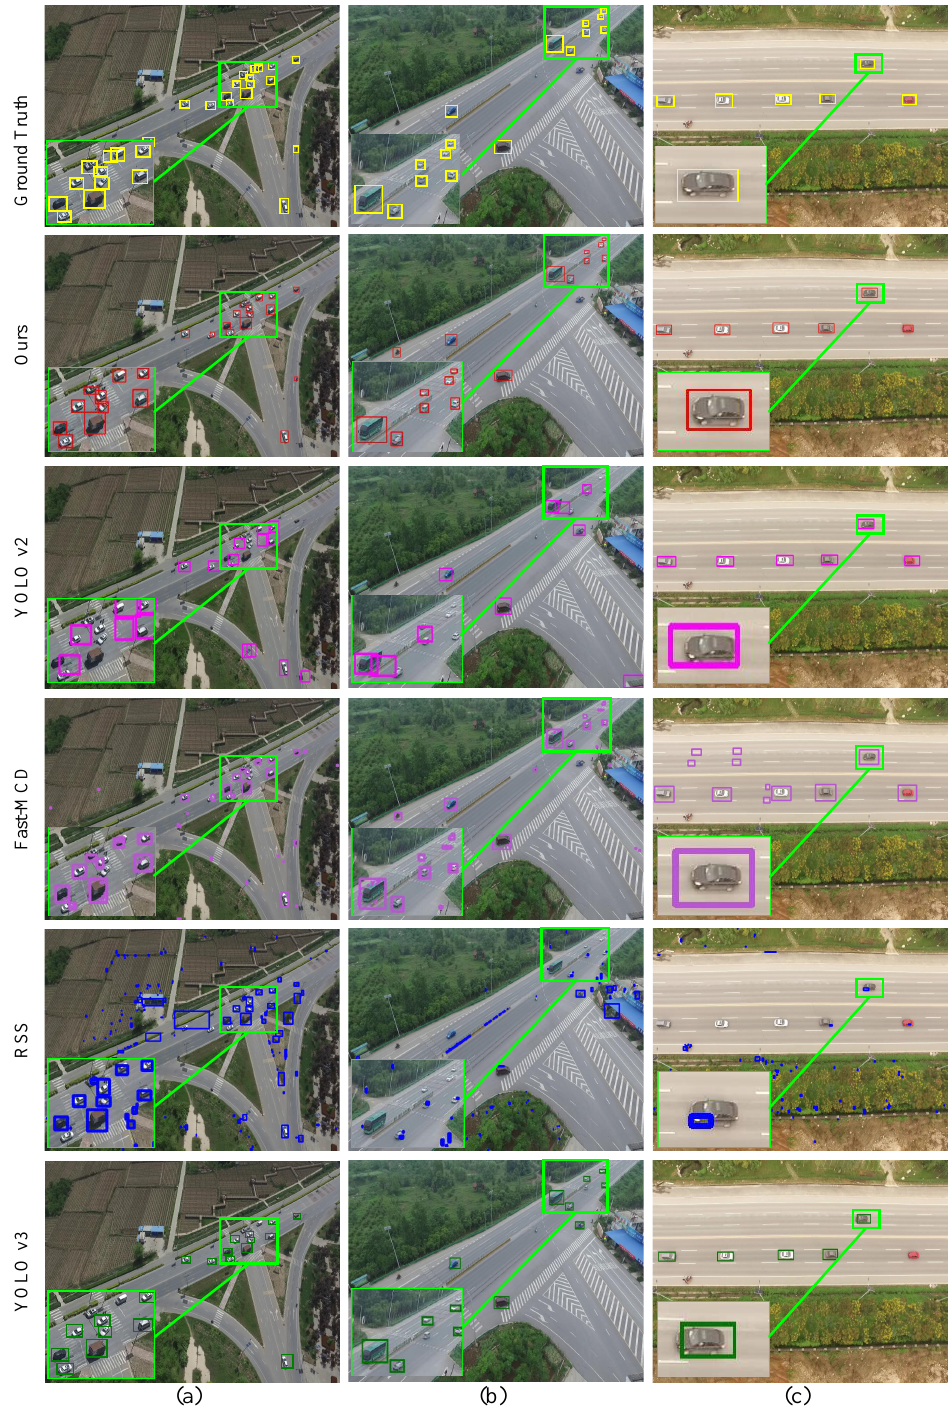
Figure 10. Some detection results of the contrast methods in three scenarios, including ( a ) a traffic crossing, ( b ) T-junction and ( c ) busy trafficway. The rectangles in the lower left corner are the enlarged details. As we can see, the detection results of the proposed method were better than those of the comparison methods in terms of completeness and